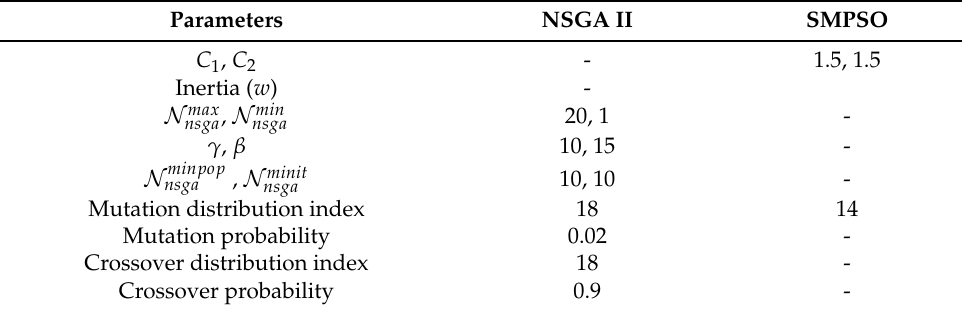
Table 3. Parameter selection for different phases of the SONG algorithm. Parameters NSGA II SMPSO C 1 , C